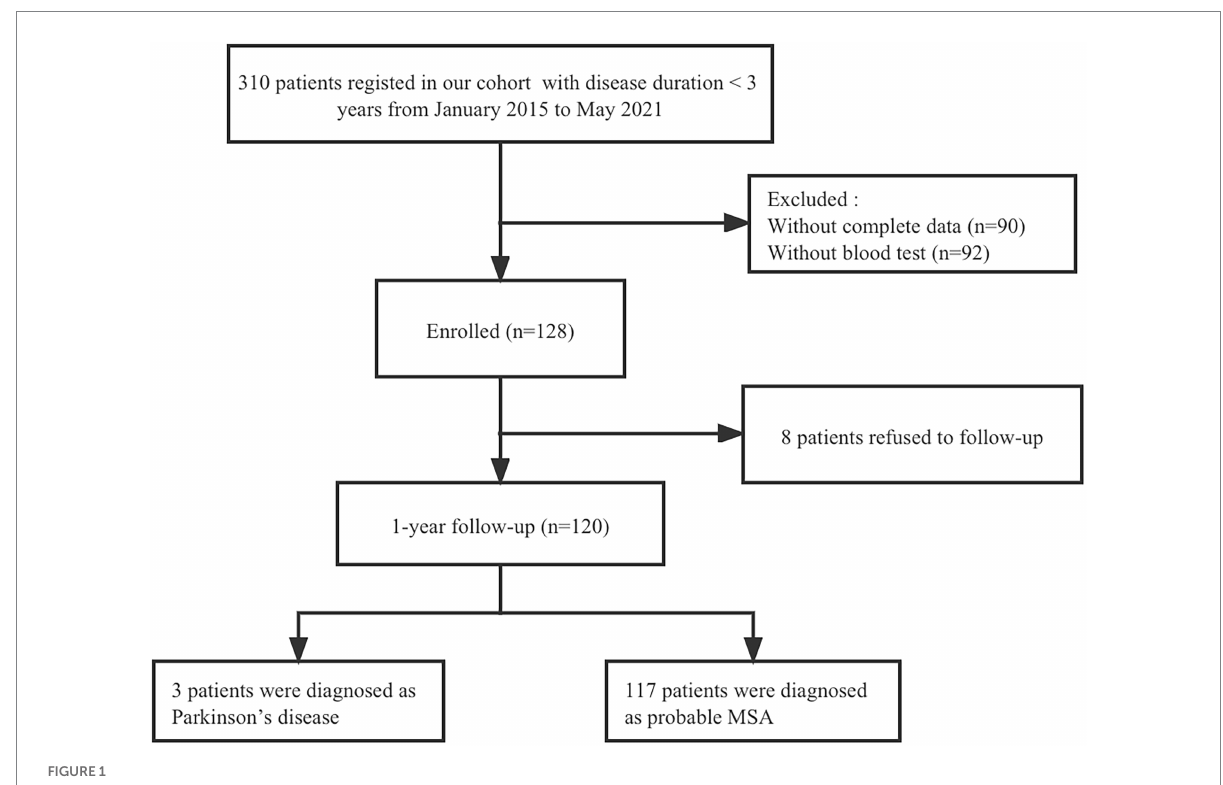
FIGURE 1 Study flow